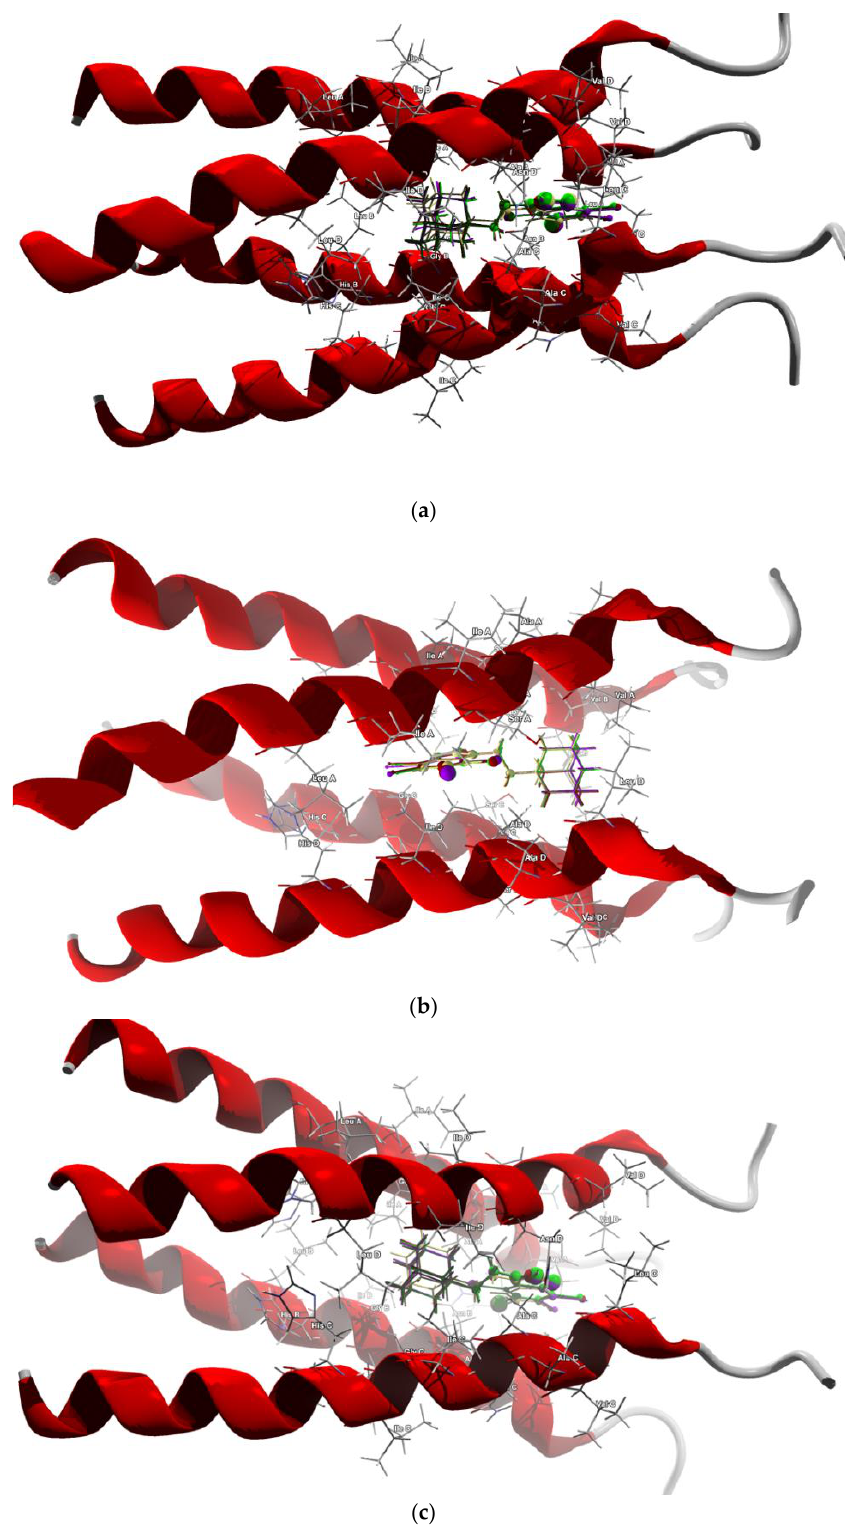
Figure 11. The docked poses of compound AB (yellow), tClAB (green), tBrAB (burgundy) and tIAB (purple) in binding site of Membrane Protein, M2: ( a ) 2LY0, ( b ) 2MUW, ( c ) 2MUV. The protein back- bone is represented as a cartoon, the binding cavity residues are shown as sticks and docked ligands are shown as ball and stick (the size of the ball is proportional to the strength of the